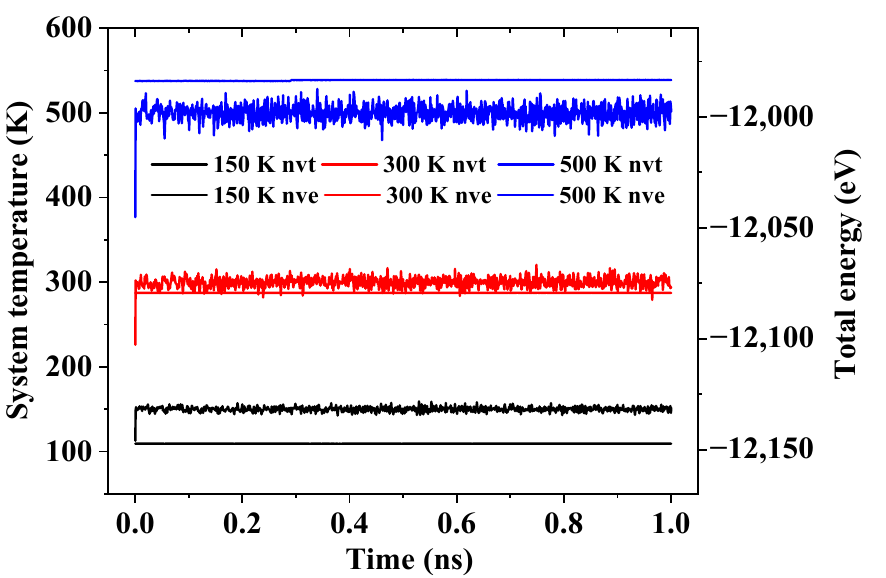
Figure 10. Convergence of system temperatures and system total energies during relaxation.